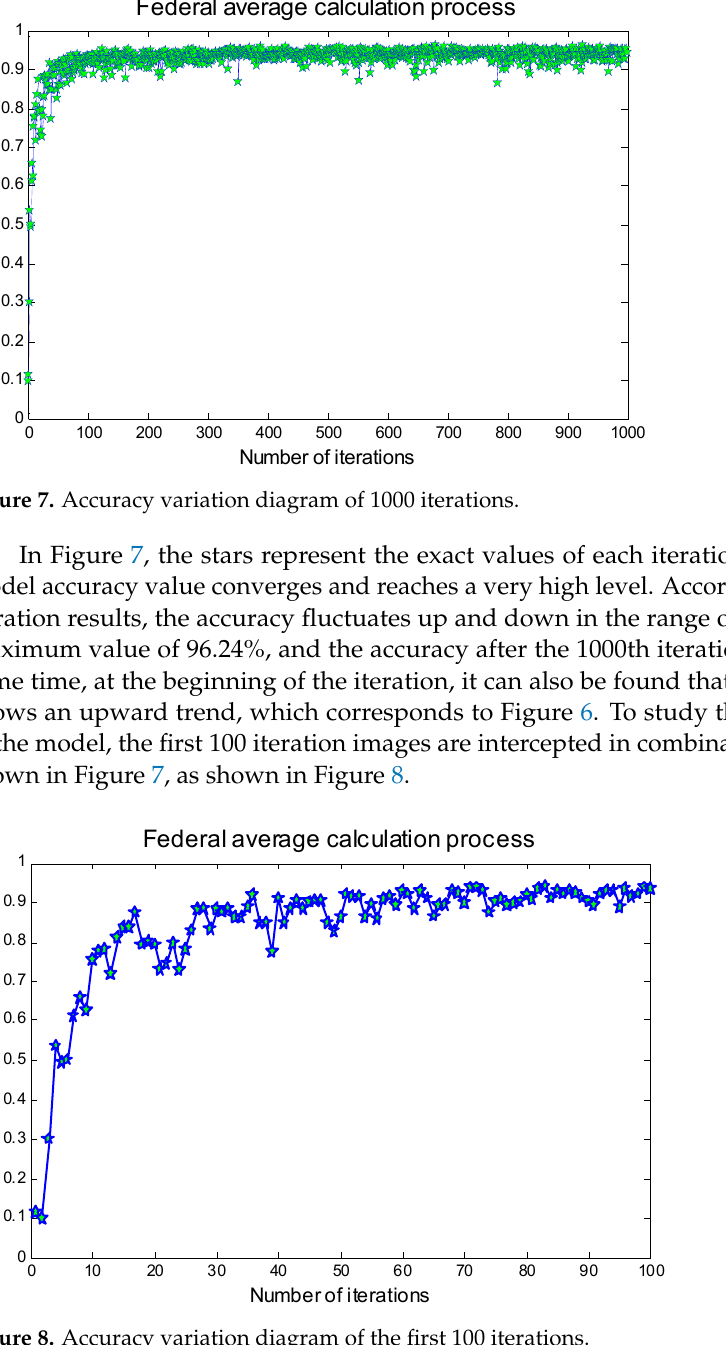
Figure 8. Accuracy variation diagram of the first 100 iterations.